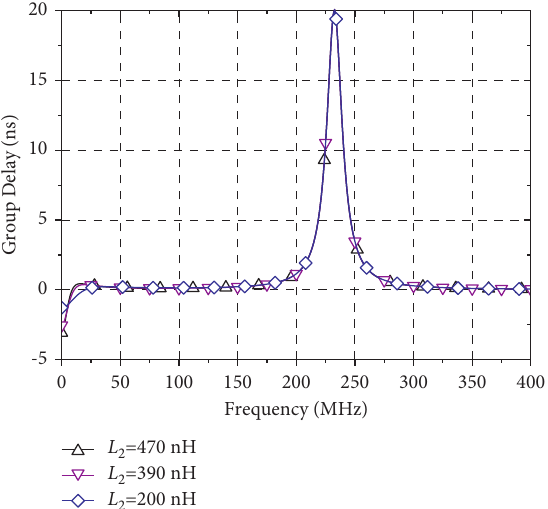
Figure 18: Low-pass negative group delay of the band-stop filter with different inductance values ( L